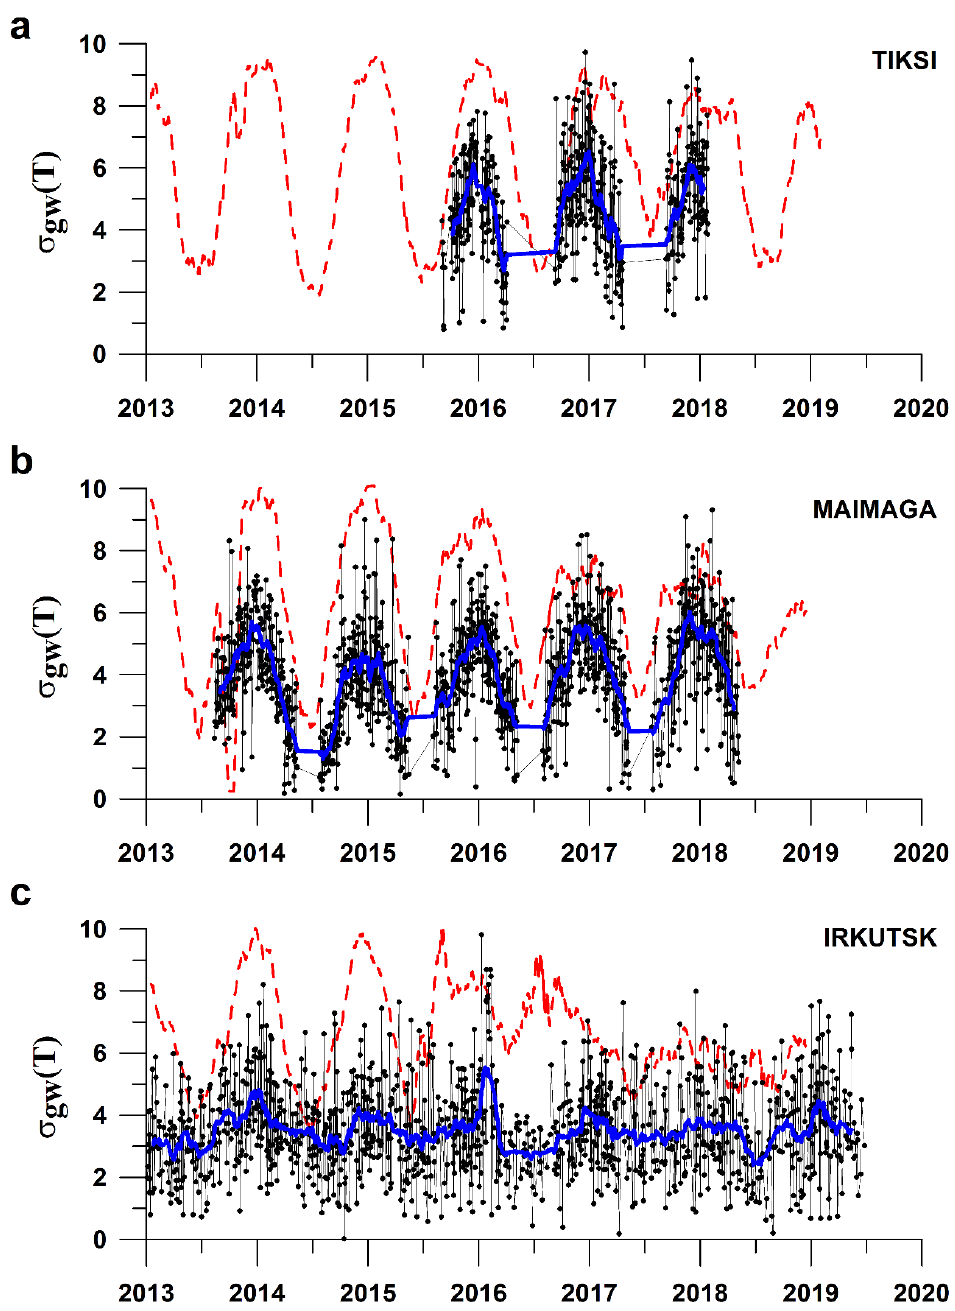
Figure 2. IGW component σ gw (T) variations within the mesopause temperature data (dots). The dark blue line superimposes the running mean with a 27-day window. Red dashed lines show the seasonal variations in TEC variability in half-scale of amplitude for corresponding regions.